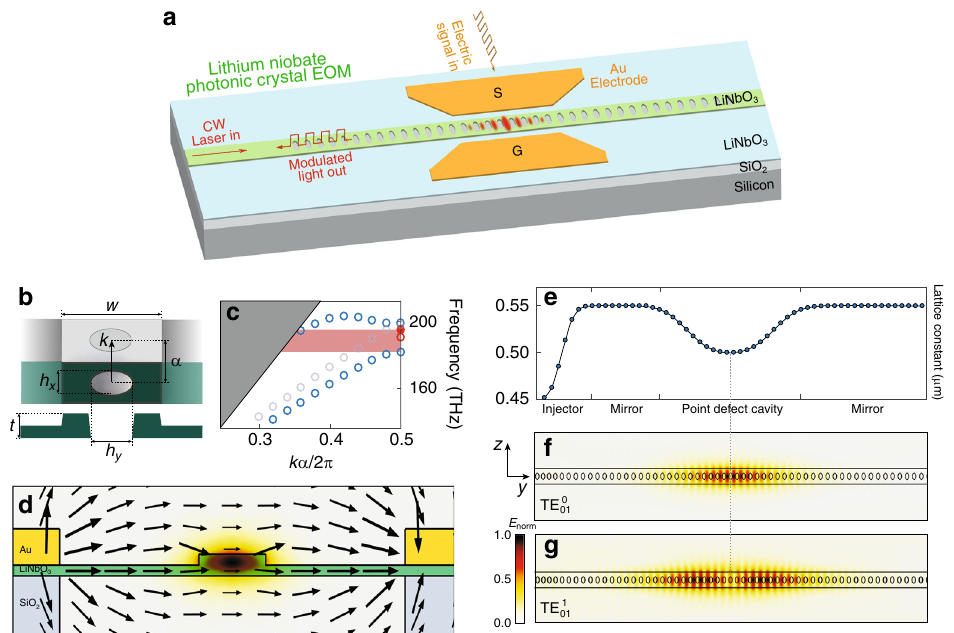
Fig. 1 Design of LN photonic-crystal EOM. a Schematic of the LN photonic-crystal EOM. b The structure of the unit cell (top: top view; bottom: cross- sectional view). The LN photonic-crystal nanobeam has a width of w = 1200 nm, layer thickness of t = 300 nm, and a partially etched wing layer with a thickness of 150 nm. The elliptical hole has dimensions of h x = 270 nm and h y = 490 nm, and a fully etched depth of 300 nm. a is the lattice constant. The full cross-section is shown in d . c Dispersion property of the partially etched LN photonic-crystal nanobeam, simulated by the fi nite element method (FEM). The blue open circles show the dielectric and air bands. The red solid and open circles denote the fundamental and second-order TE-like cavity modes shown in f and g . Our simulations show that there exhibits another mode with eigenfrequency within the band gap (gray open circles). This mode, however, has only negligible perturbation to the dielectric mode due to distinctive spatial symmetry, thus not affecting the quality of the defect cavity mode. d Cross-sectional schematic of the EOM structure, where the arrow pro fi le shows the radio frequency (RF) electric fi eld distribution and the color pro fi le shows the optical cavity mode fi eld distribution, both simulated by the FEM method. e Lattice constant a as a function of position, which is optimized for low insertion loss together with high radiation-limited optical Q . f Top view of the FEM-simulated optical mode fi eld pro fi le of the fundamental TE-like cavity mode TE 0 . The left inset shows the orientation of the LN crystal where the optical axis is along the z direction. g Simulated optical mode fi eld pro fi le 01 of the second-order TE-like cavity mode TE 1 . The scale bar on the left represents the strength of normalized electrical fi eld ( E norm ) for d , f , g . 01